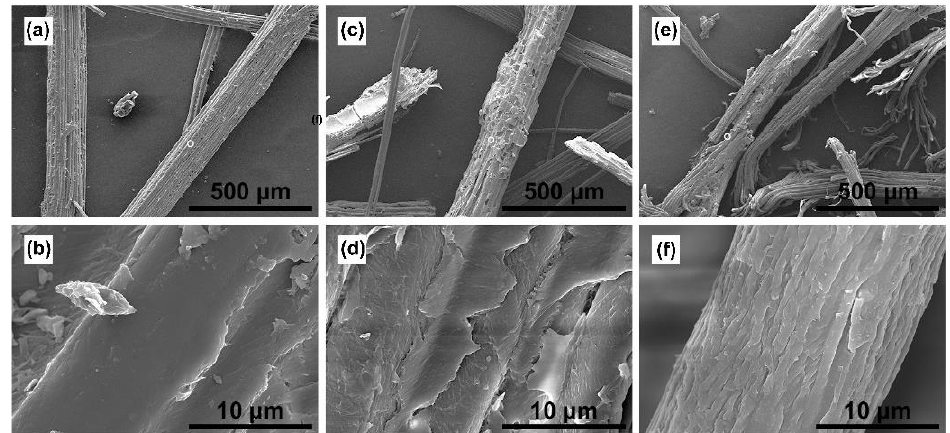
Figure 3. SEM of bamboo before and after different treatments (( a / b ), Raw material; ( c / d ), after weak-alkali treatment; and ( e / f ), freeze – thaw-assisted alkali treatment).